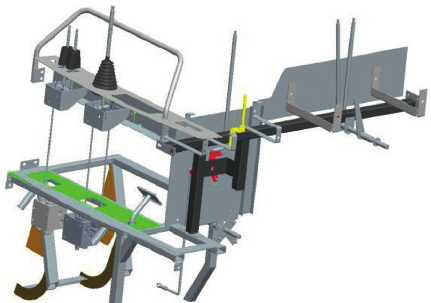
Figure 14: Internal structure of the operating